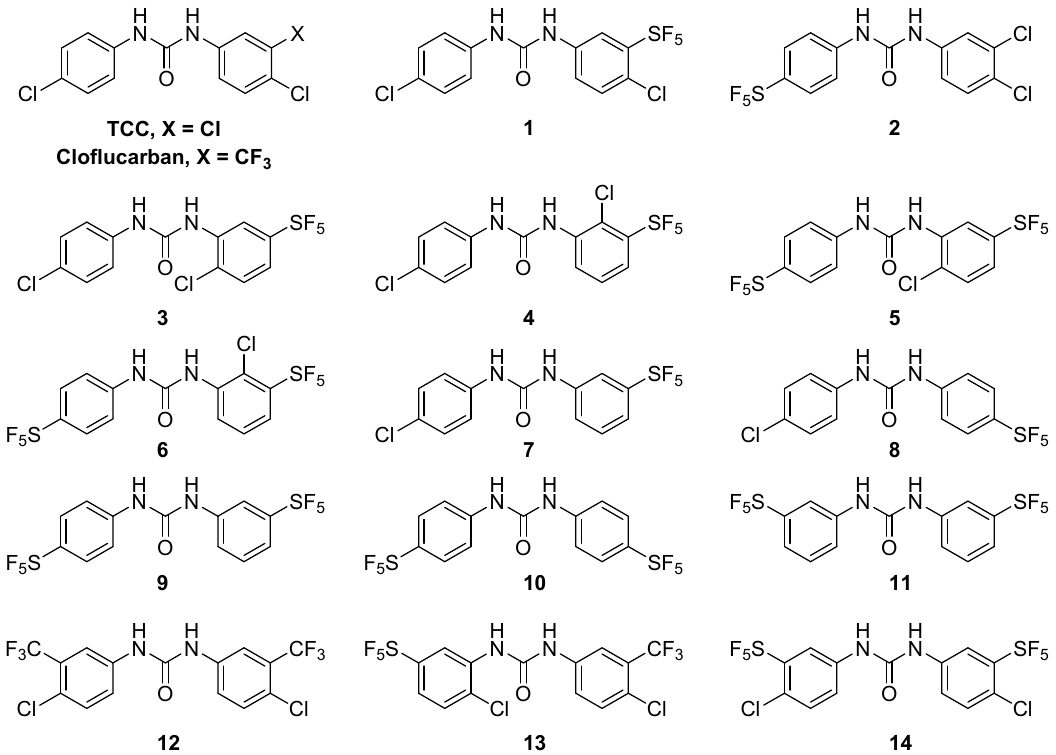
Figure 2. Pentafluorosulfanyl ureas 1 – 14 . Compounds 1 to 6 and 8 are new. Compounds 9 , 11 , 13 and